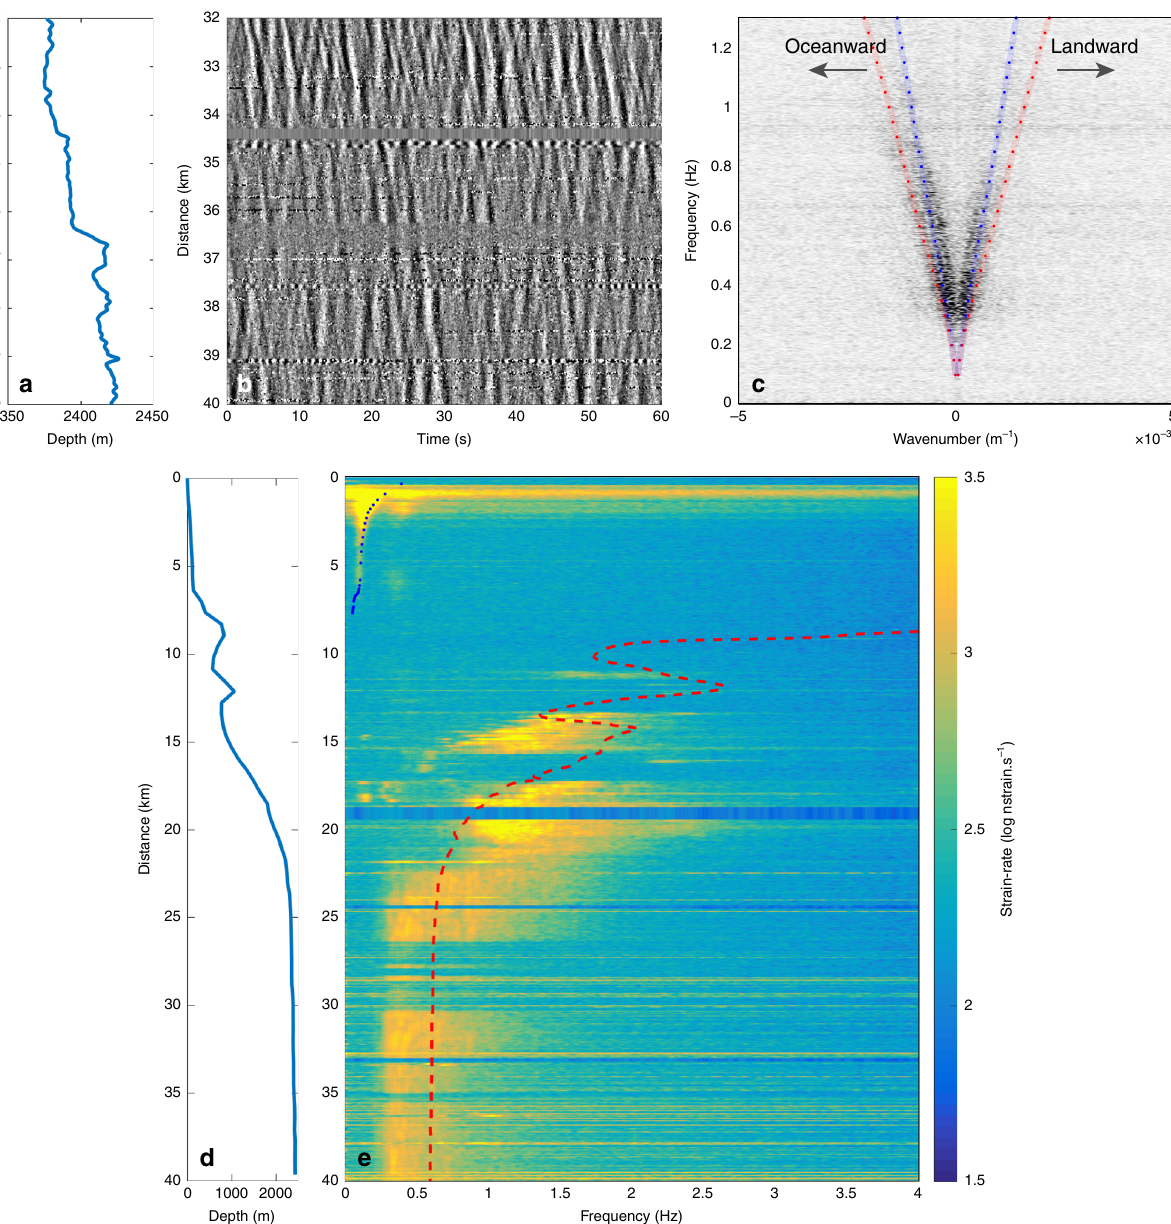
Fig. 3 Observations of oceanic secondary microseismic noise. a Depth pro fi le of the OF cable. b 60 s record of strain-rate between km 32 and 40. c f – k decomposition of the signal. The dotted lines are the modeled frequencies of peak amplitude (minimum group velocity) of the fundamental mode of Scholte waves assuming a regional velocity model 26 (Supplementary Fig. 2) and varying the P-wave velocity in the top sedimentary layer (1500m/s in red and 2000m/s in blue). d Depth pro fi le of the OF cable along its full length. e Spectrum of the noise along the cable. The pressure directly produced by the swell vanishes at a depth that depends on frequency as predicted by linear theory (blue dotted curve shows predicted depth of 95% amplitude loss). Beyond 8 km from the coast, at depths larger than 200 m, the OF cable senses the second-order pressure fl uctuations caused by the sea surface waves. In deep water, the frequencies of maximum energy are consistent with those predicted from the water column resonance effect that ampli fi es the Scholte waves (red dashed